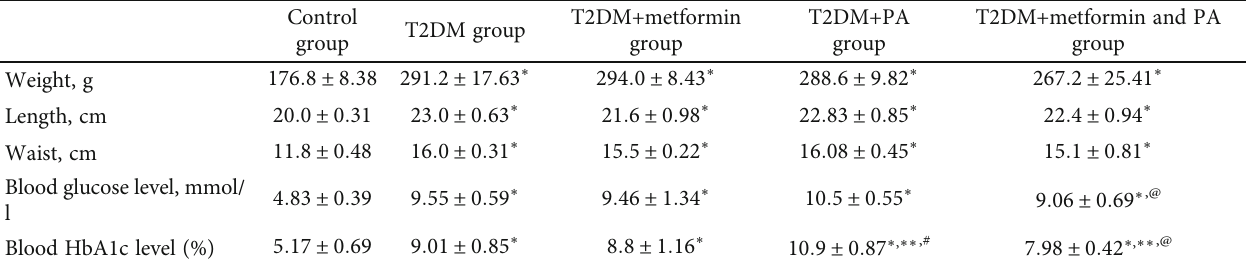
Table 2: The animal body parameters, blood glucose, and HbA1c after diabetes induction. Control